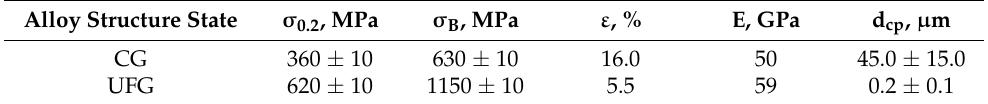
Table 2. Mechanical properties of Ti-45Nb alloy